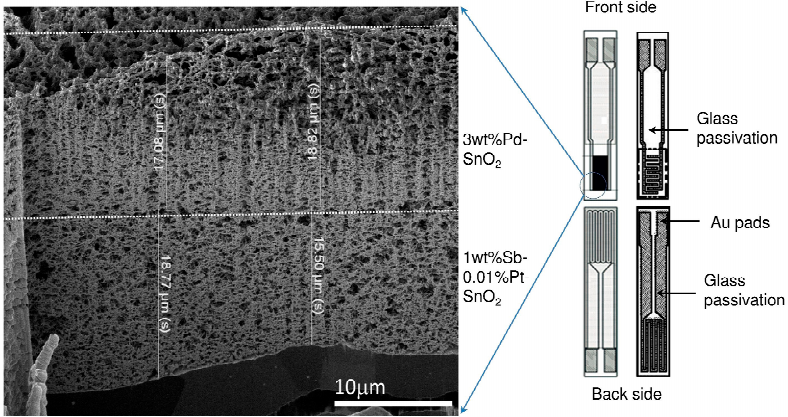
Figure 3. The focused ion beam (FIB) image of a double sensing layer composed of 1 wt % Sb–0.01 wt % Pt-SnO 2 //3 wt % Pd-SnO 2 . The total layer thickness was found to be approximately 35 (±2) µm ( Left ); Layout of the sensor substrates: Interdigitated platinum electrodes with trace/gap of 10 µm, 30 µm, and 100 µm, respectively, platinum heater on the backside. Heater and conductive pads to the electrodes are passivated ( Right ).